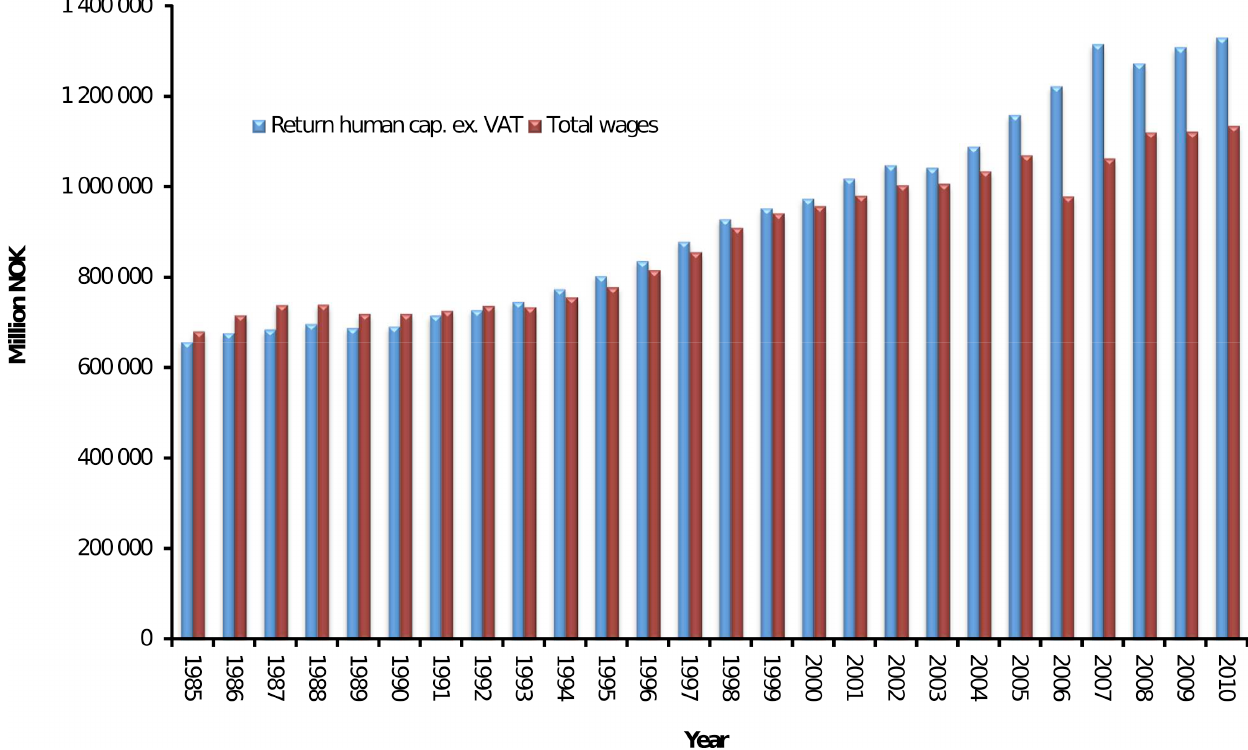
Figure 4. Estimated returns to human capital in Norway compared to total wages paid